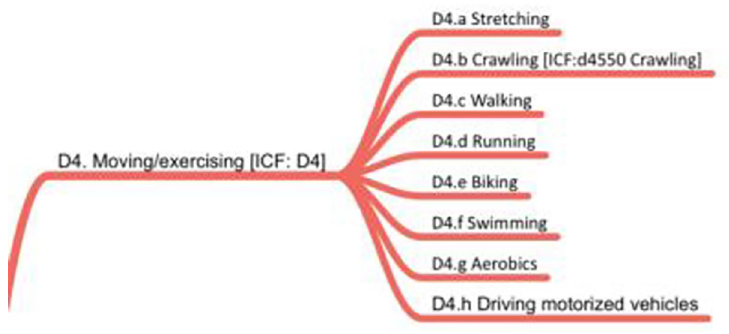
Fig 6. D4 domain on